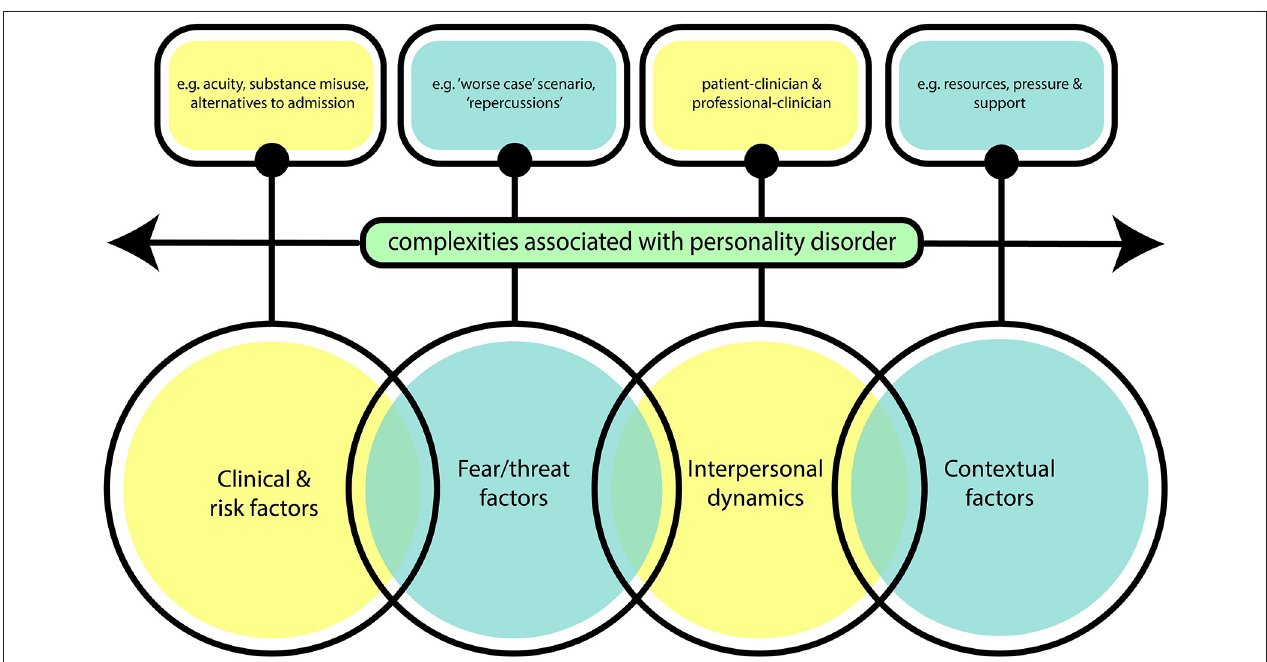
FIGURE 2 | Figurative representation of key